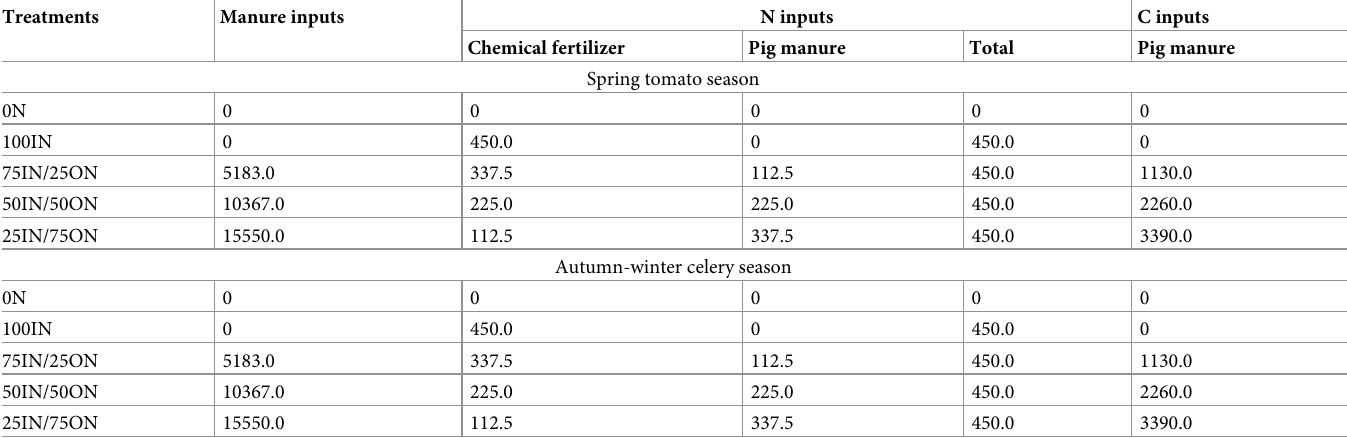
Table 2. Manure, nitrogen and carbon inputs (kg ha − 1 ) used in each treatment during the spring tomato season and autumn-winter celery season.